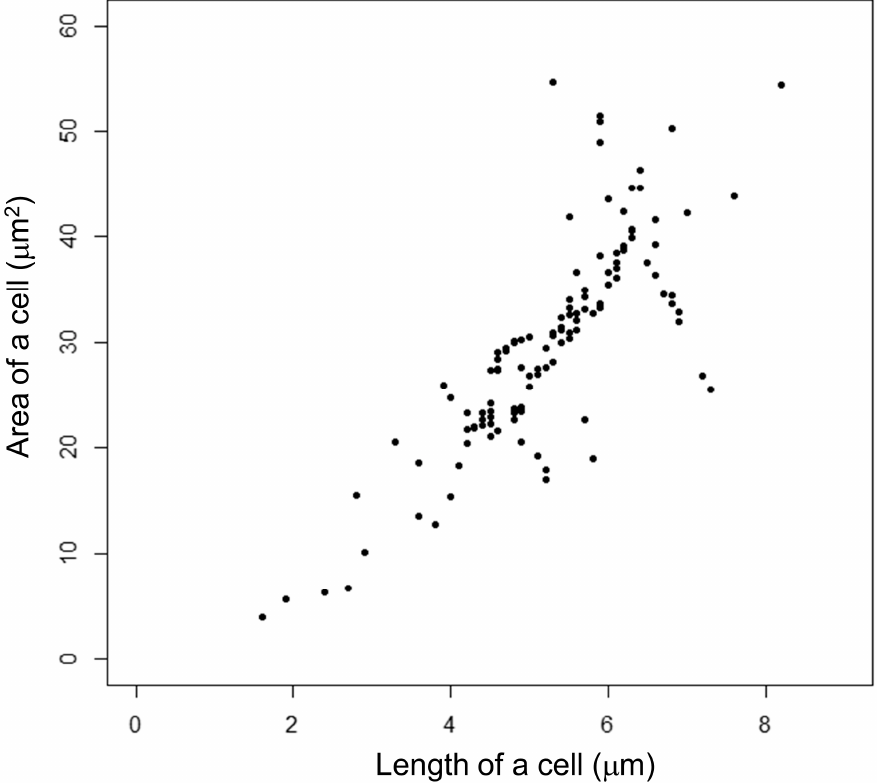
Figure 5. Automatically measured cell area vs. cell length.